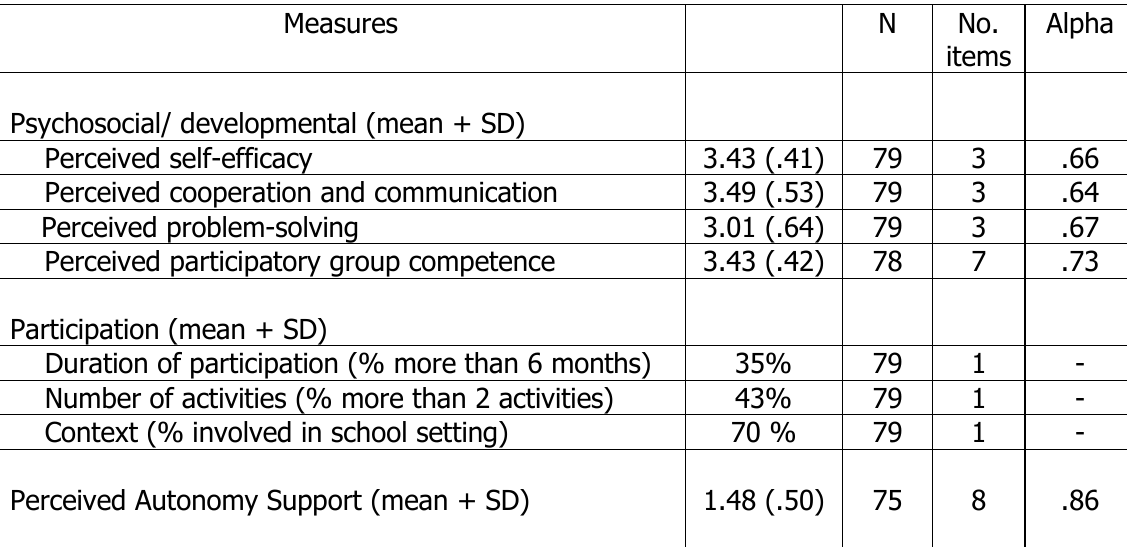
Means and standard deviations for psychosocial, participation and perceived autonomy support